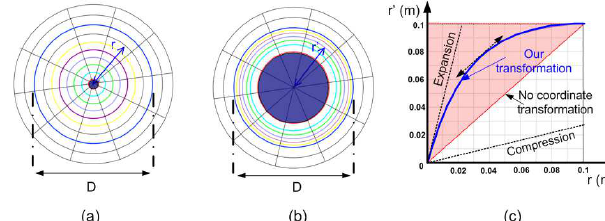
Figure 11: (a) initial space, (b) transformed space, (c) the blue curve shows the transformation rule made of an expansion followed by a